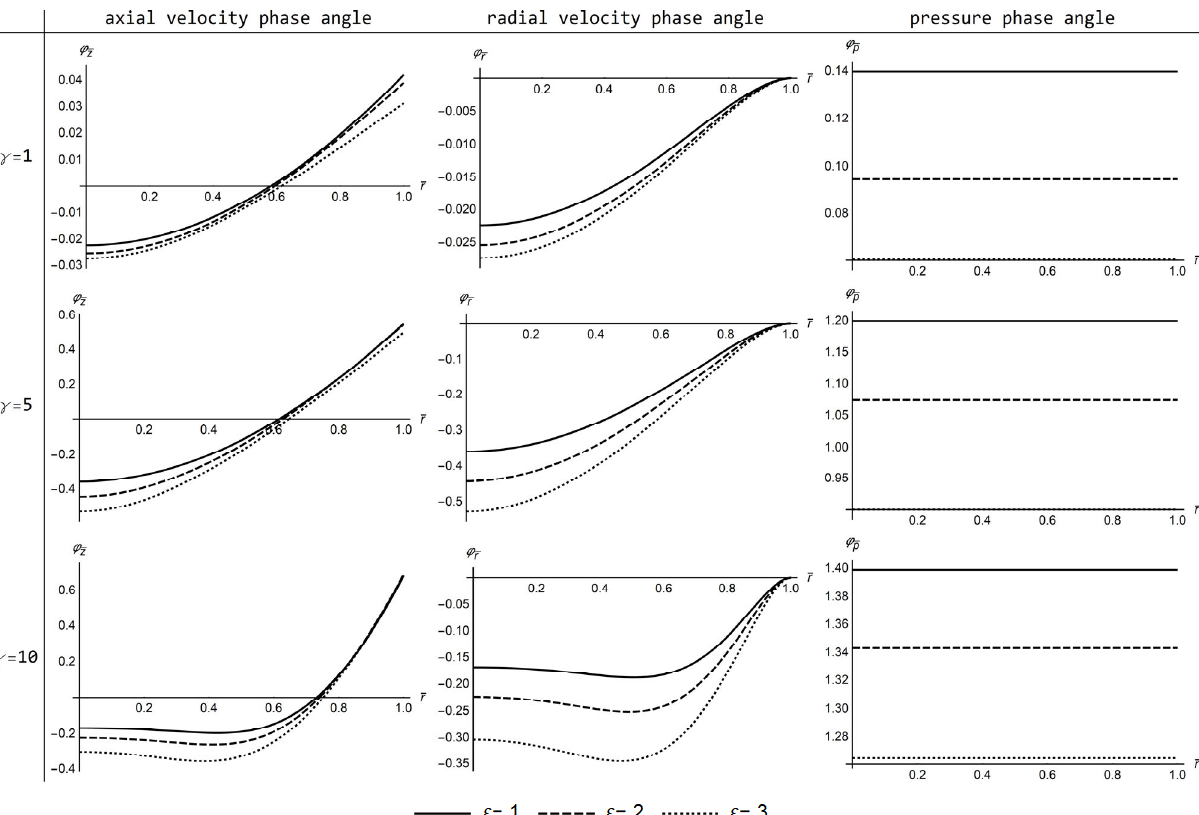
Figure 4. Profiles of the axial velocity, radial velocity and pressure phase angles for different values of the Womersley number ( γ = 1, 5, 10) and the suction/injection number ( ε = 1, 2, 3).